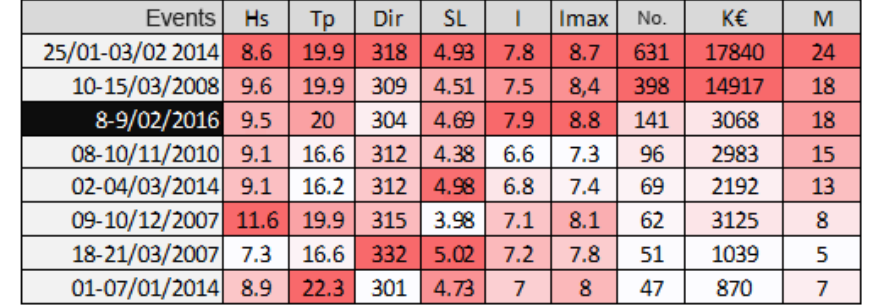
Figure 10. Some ocean–meteorological (Hs, Tp, Dir, SL) and impact-related data (#, KC, M ) for the 8 worst coastal events in Basque Country during the 21st